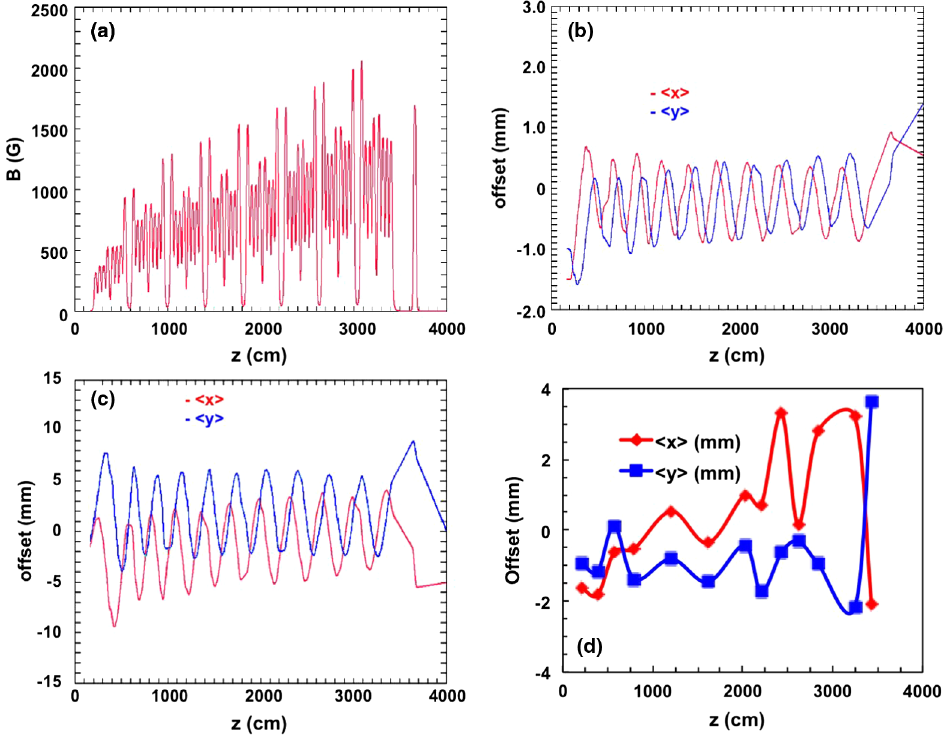
FIG. 5. (a) Solenoid lattice for a higher field tune, tune 6, for the 2.9 kA beam; (b) calculated beam centroid oscillations corresponding to this tune with initial position offsets only; (c) calculated beam centroid oscillations corresponding to this tune with initial position and assumed angle offsets of 5 mrad; (d) measured beam centroid offsets running this tune (note scale